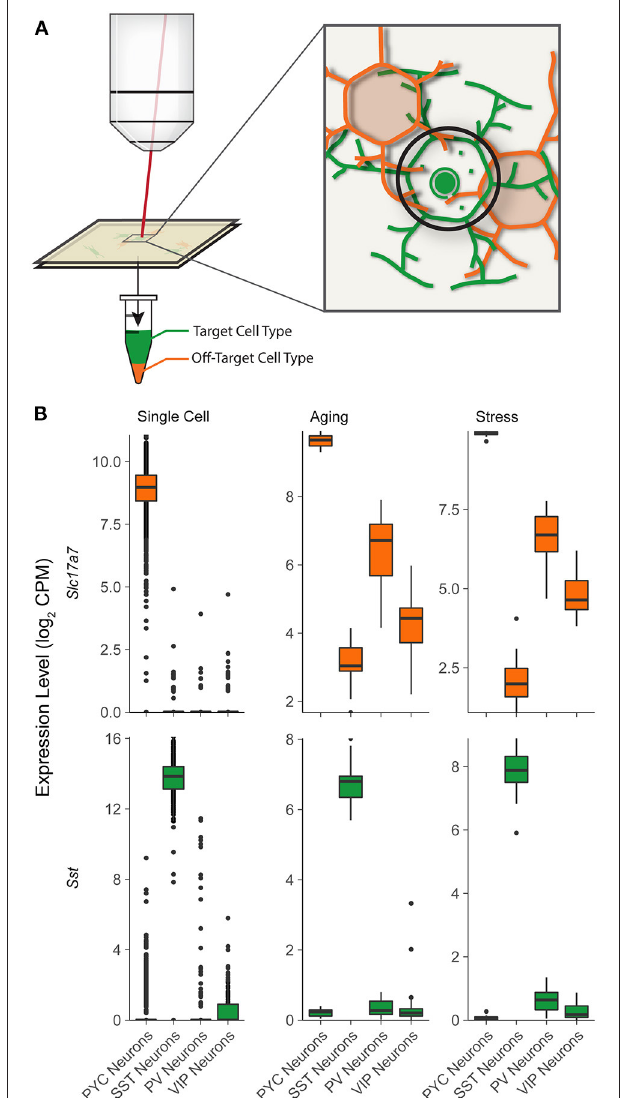
FIGURE 1 | Illustration for potential off-target cellular contamination in single-cell type RNA-seq studies. (A) A schematic showing cell targeted mRNA sampling in LCM-seq, illustrating targeted sampling of specific cells (green) along with the potential for undesired sampling from surrounding cells (orange). In this case, the desired SST interneuron (green) will be microdissected by cutting around the black path. In this area, processes of the orange cell (orange) lay above and below the targeted cell (green). (B) Expression levels of characteristic cell type specific marker genes for pyramidal cells ( Slc17a7 ) and SST interneurons ( Sst ) in “Single Cell” (single cell Allen Brain Institute reference data) and two LCM-Seq experiments: “Aging” (GSE119183) and “Stress” (GSE145521). Note the presence of relatively high levels of Slc17a7 in samples from SST, PV, and VIP interneurons in the LCM-Seq Aging and Stress datasets, indicating likely off-target